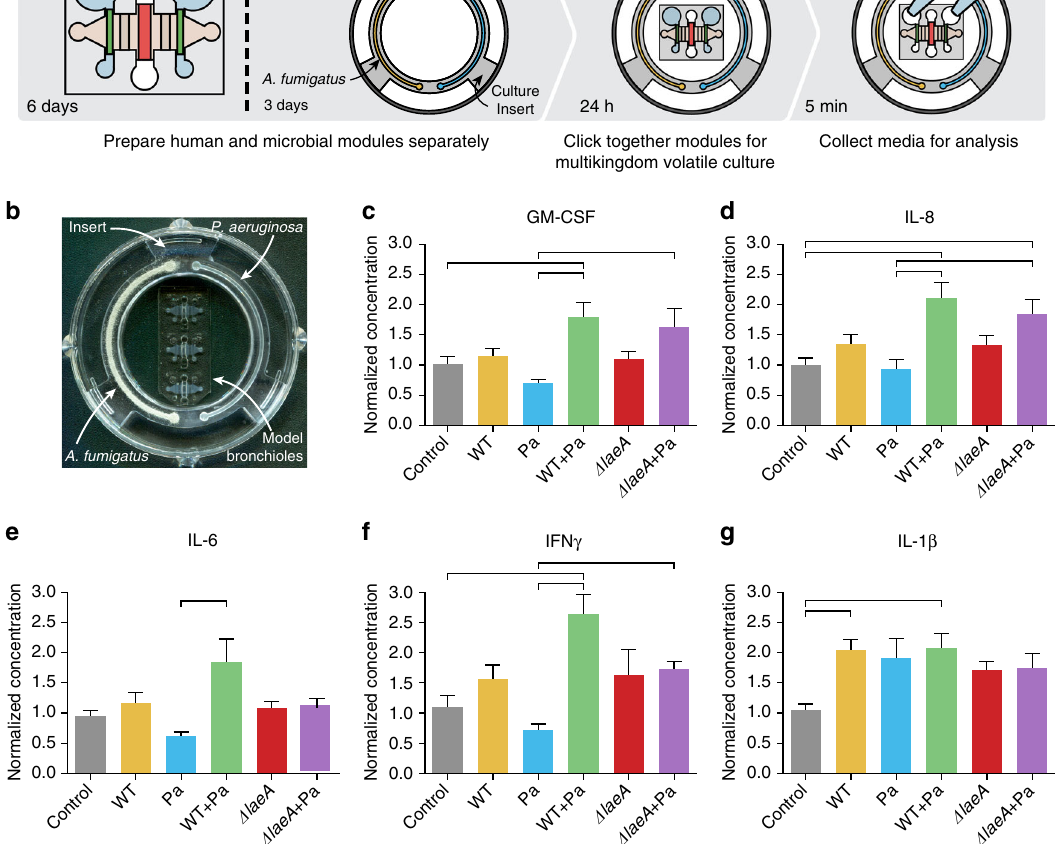
Fig. 4 Microbial volatiles impact epithelial cell secretion of in fl ammatory cytokines. a Key experimental steps. b Photo of the experimental setup. The microbial culture insert is inoculated with A . fumigatus on the left and P . aeruginosa on the right. The insert sits within a securely covered 50 mm glass bottom dish containing three organotypic bronchiole devices, thus facilitating volatile factor contact between the microbial cultures and air-exposed center lumens lined with bronchiolar epithelial cells. c – g Cytokine levels in conditioned media from the side, endothelial-lined lumens measured after 24 h of volatile coculture with an insert all non-inoculated, half WT A . fumigatus , half P . aeruginosa , half each WT A . fumigatus and P . aeruginosa , half Δ laeA A . fumigatus , and half each Δ laeA A . fumigatus and P . aeruginosa . Each plotted bar represents the mean of nine organotypic devices prepared on three separate days and error bars represent standard error of the mean. Data were analyzed using an ordinary one-way ANOVA with Tukey ’ s multiple comparisons test and horizontal brackets denote comparisons between conditions that are statistically signi fi cant ( p -value < 0.05). Additional cytokines from this experiment are presented in Supplementary Fig.